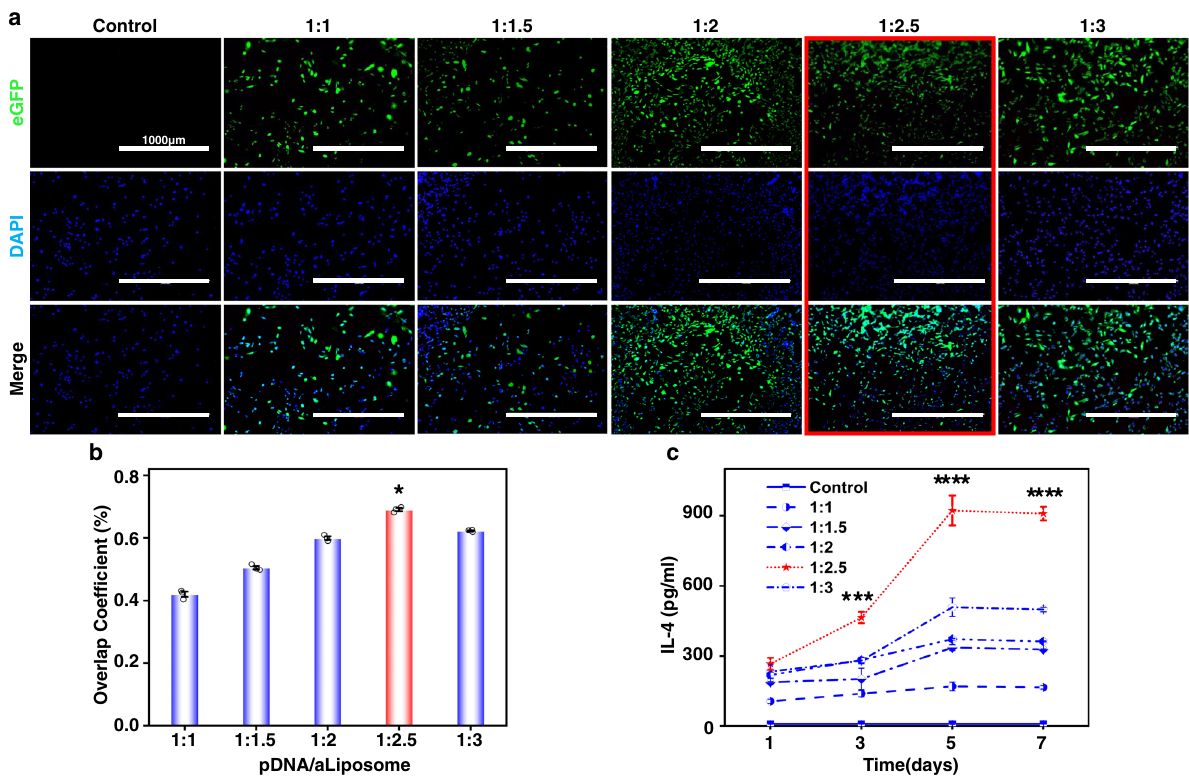
Fig. 3 Transfection ef fi ciency of aldehyde cationic liposomes. a GFP expression indicated by green fl uorescence in BMSCs after transfecting 72 h (scale bars were 1000 µ m, 2 independent experiments). b Analysis of nuclear and eGFP fl uorescence overlap coef fi cient rate ( n = 3, values were mean ± std. dev., * p < 0.05 when comparing 1:2.5 and other ratios of pDNA/aLiposome via one-way analysis of variance (ANOVA) with Tukey ’ s post hoc test). c Quanti fi cation of the IL-4 secretion after 1, 3, 5, and 7 days of transfection ( n = 3, values were mean ± std. dev., *** p < 0.001, **** p < 0.0001 when comparing 1:2.5 and other ratios of pDNA/aLiposome via one-way analysis of variance (ANOVA) with Tukey ’ s post hoc test at the same time point). The red box, column chart, and dashed line represented the highest group of transfection ef fi